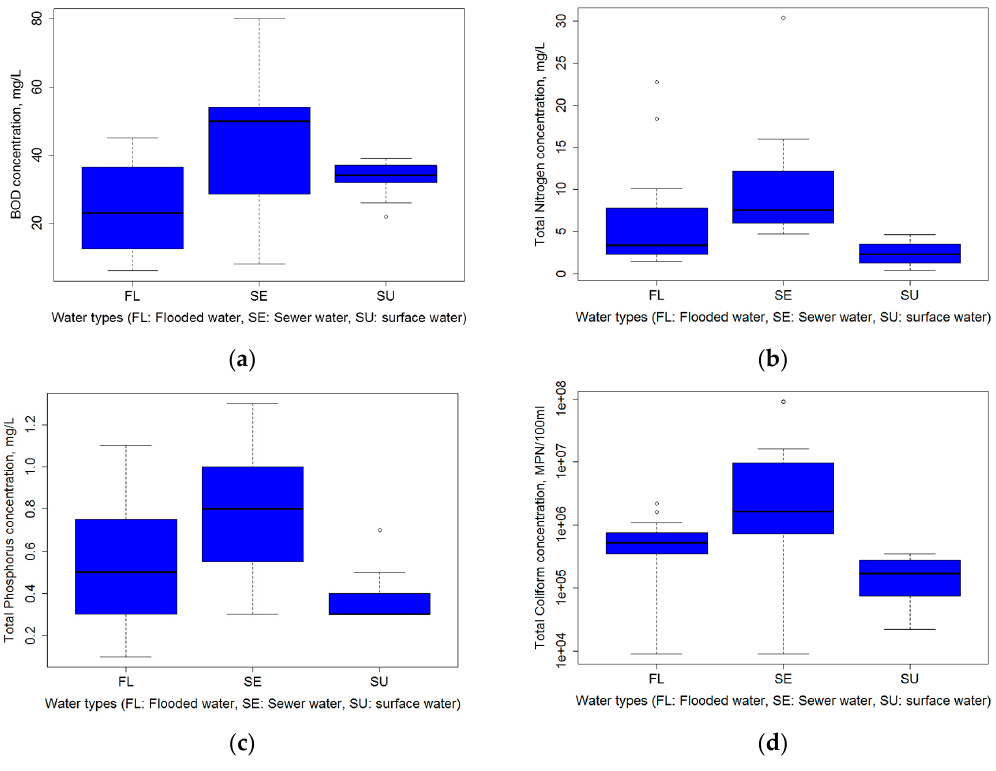
Figure 4. Box plots of BOD ( a ), Total Nitrogen ( b ), Total Phosphorus ( c ) and Total Coliform ( d ) during the flood event among water bodies. the flood event among water